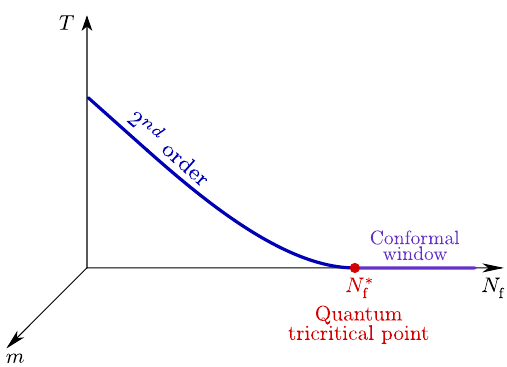
Figure 14. Suggested phase diagram for the chiral phase transition as a function of N f